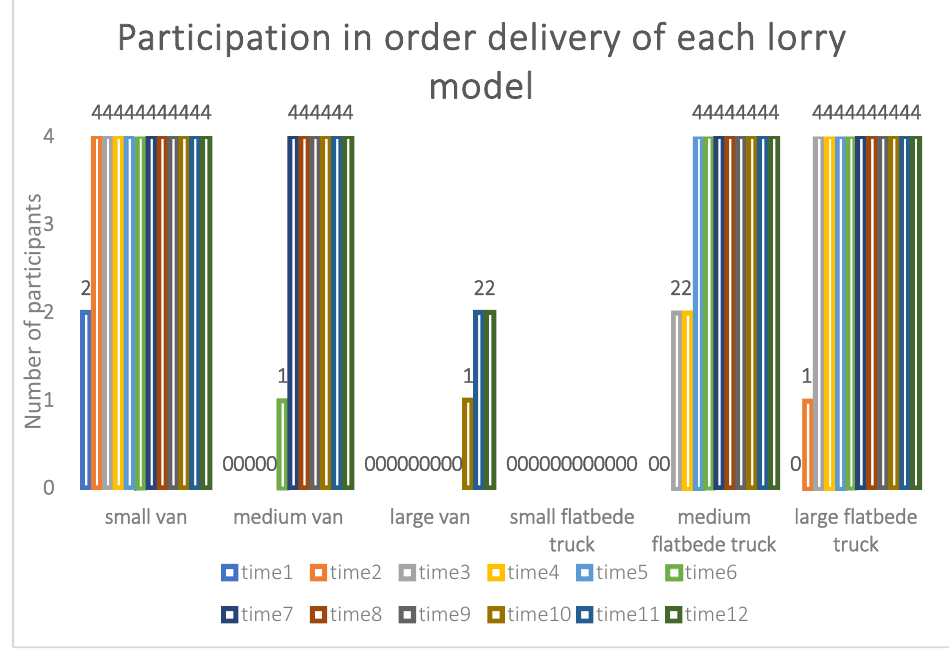
Figure 3. Order distribution of different models.